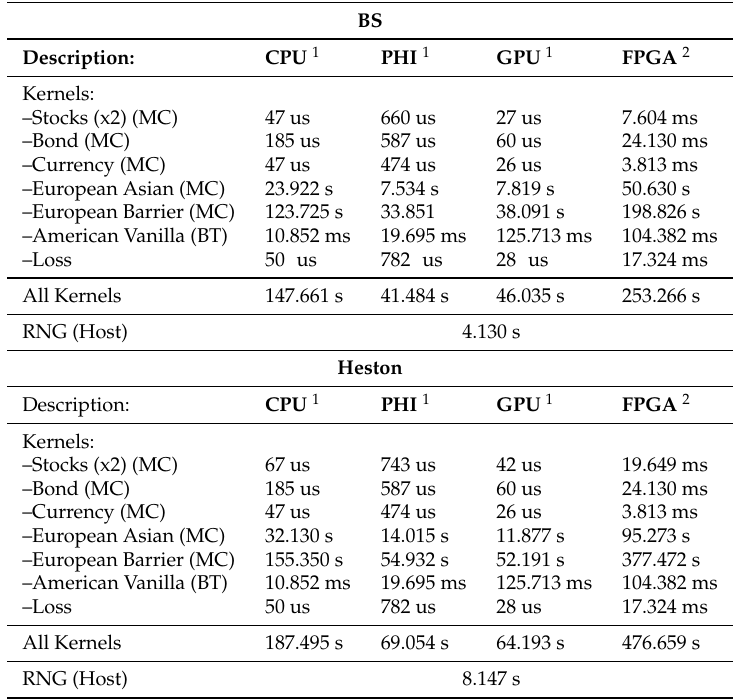
Table 3. Runtime breakdown (s) with external RN sequences—( pathsMCext/pathsMCint ) = (32 k /32 k